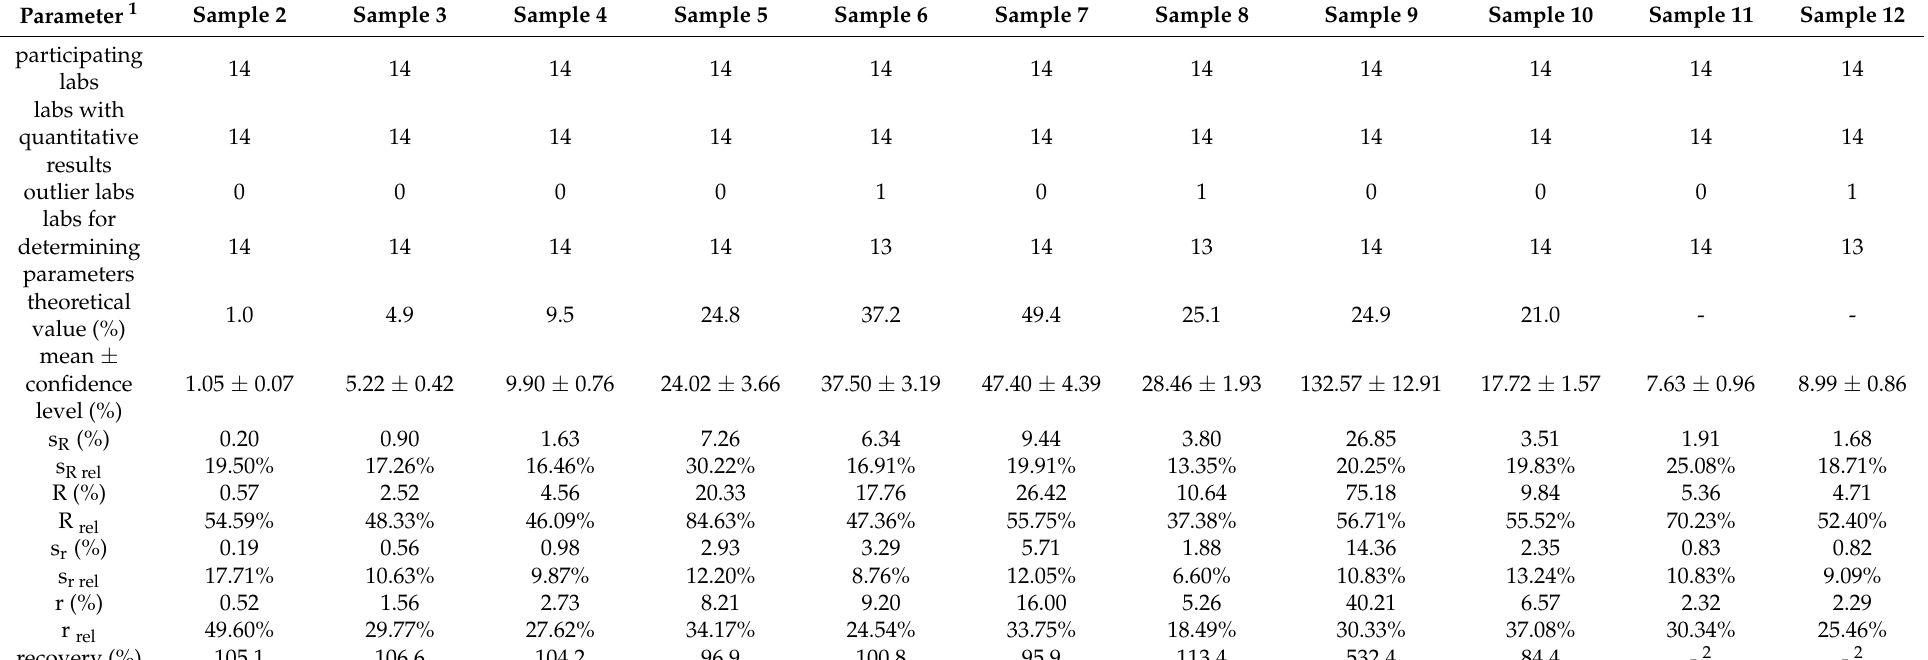
Table 7. Summary of the statistical parameters for determining the roe deer content in meat samples. The distribution of readings for sample 8 deviates statistically significantly from the normal distribution. Therefore, the results for this sample have limited